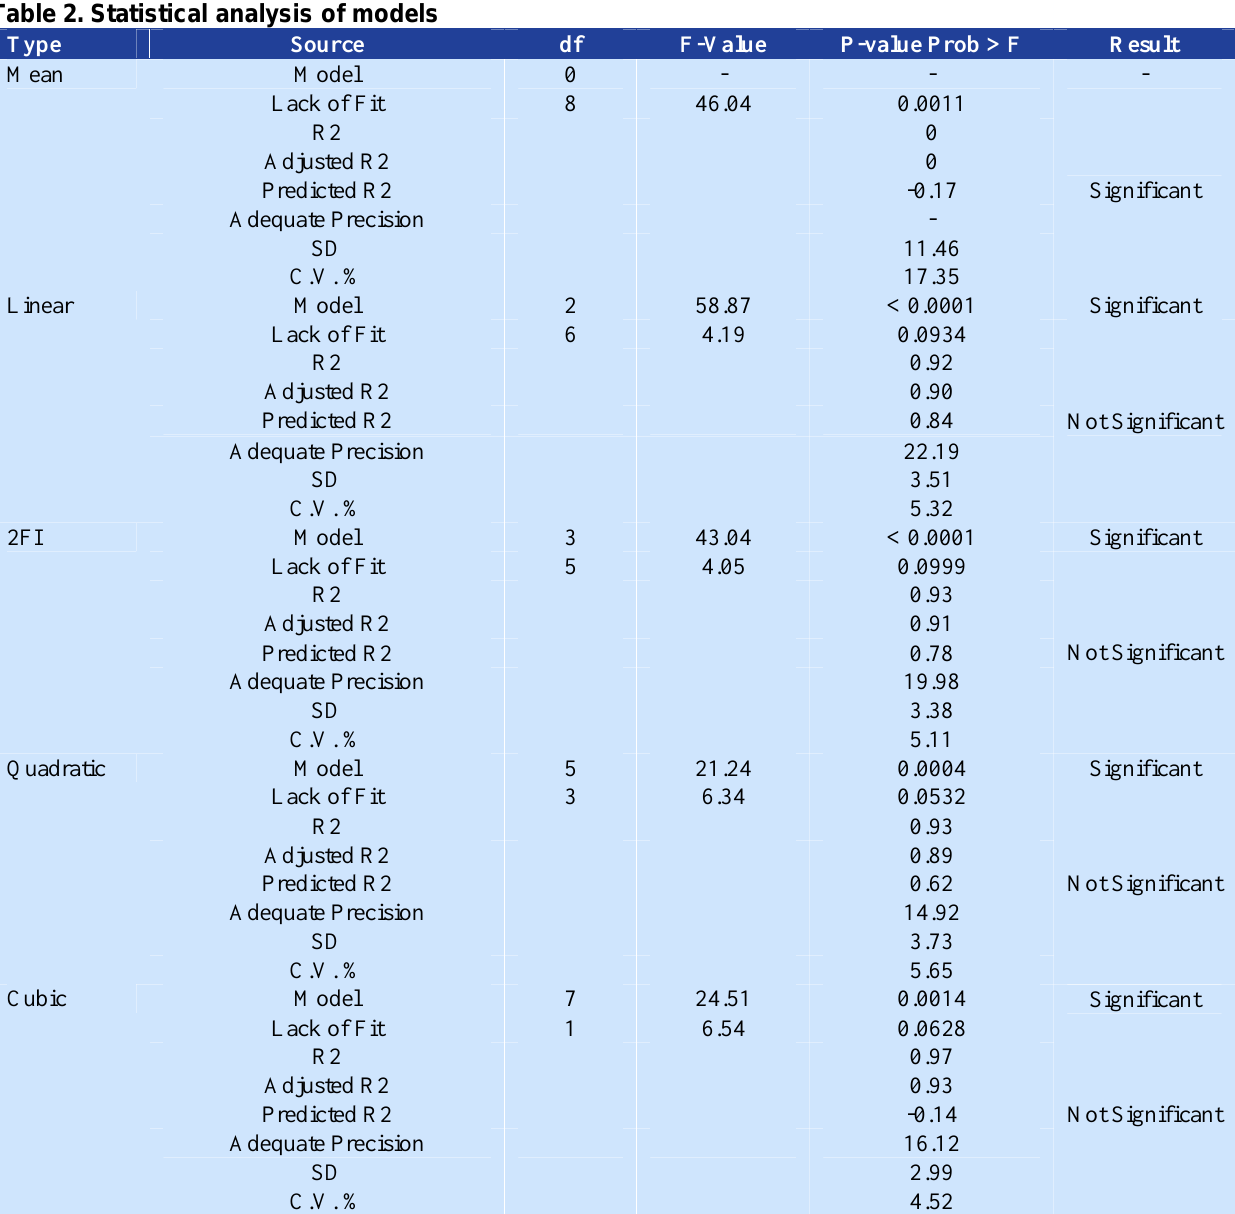
Table 2. Statistical analysis of